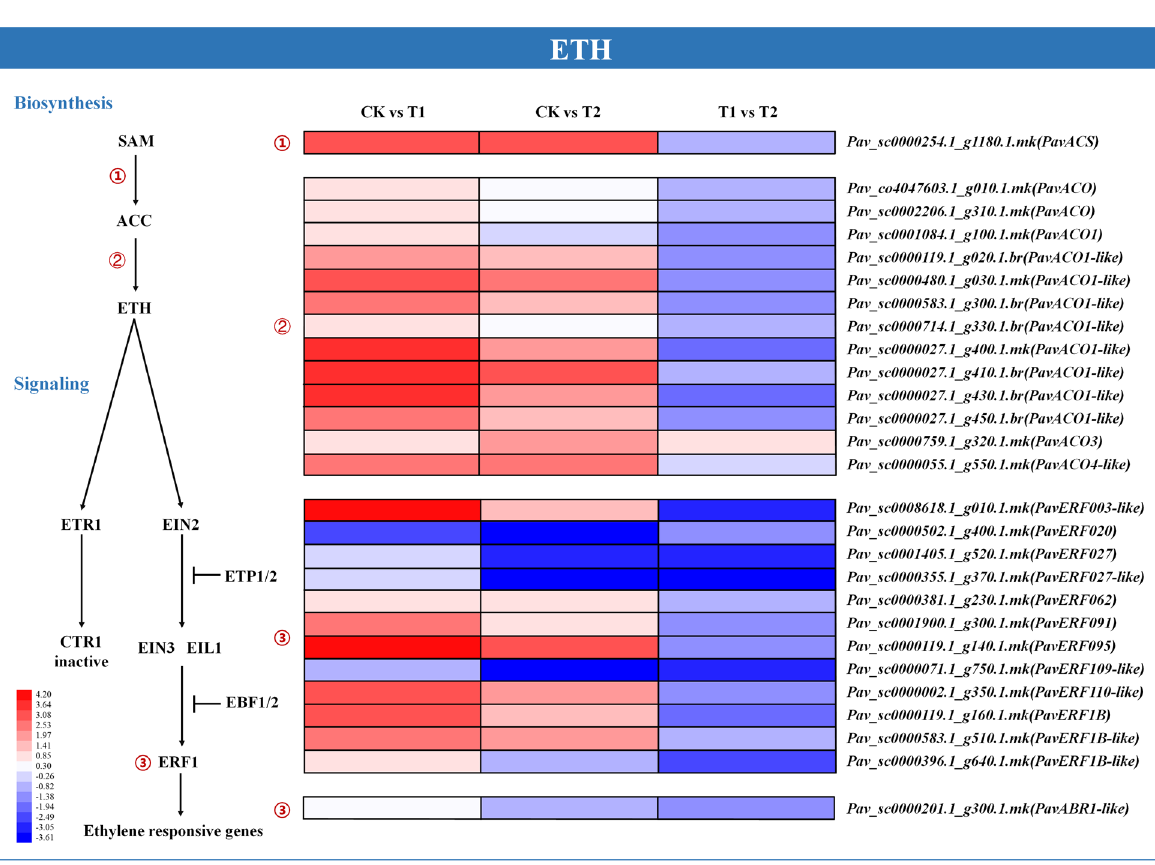
Fig. 7 Expression profiles of differentially expressed genes (DEGs) related to ethylene (ETH) biosynthesis and signaling pathways, represented using a heatmap. The scale of color intensity is shown in the lower left quarter of heat map representing the log2fold-change values. Fold-change refers to the ratio of gene expression levels in cherry rootstock leaves between control (CK) and treatments